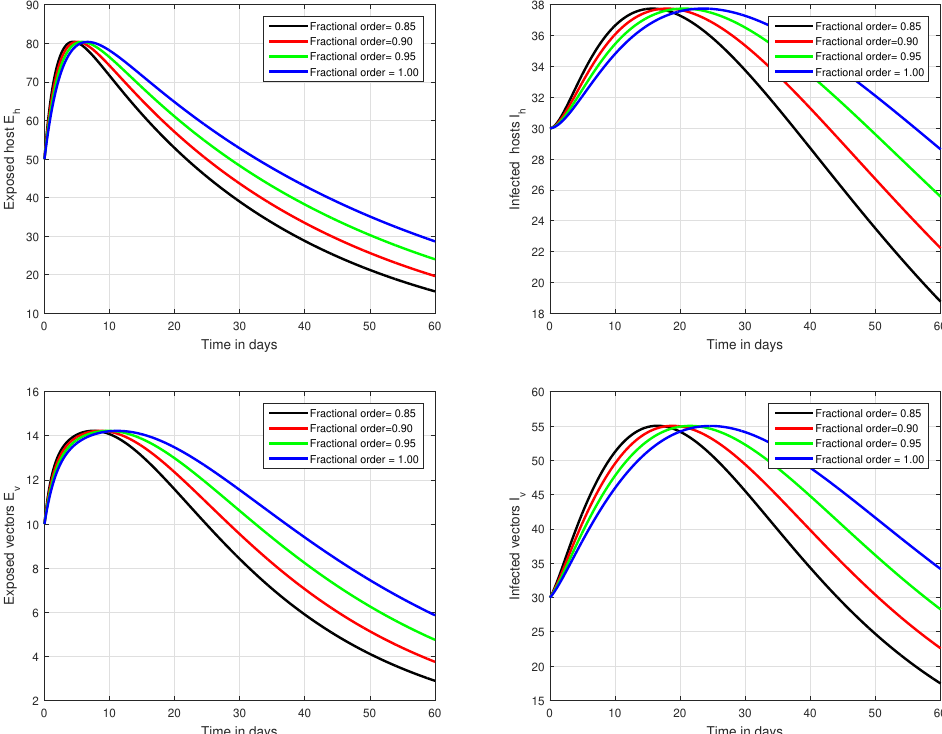
Figure 1. Time series analysis of the proposed fractional system of Zika virus infection with various fractional values, i.e., ℘ =